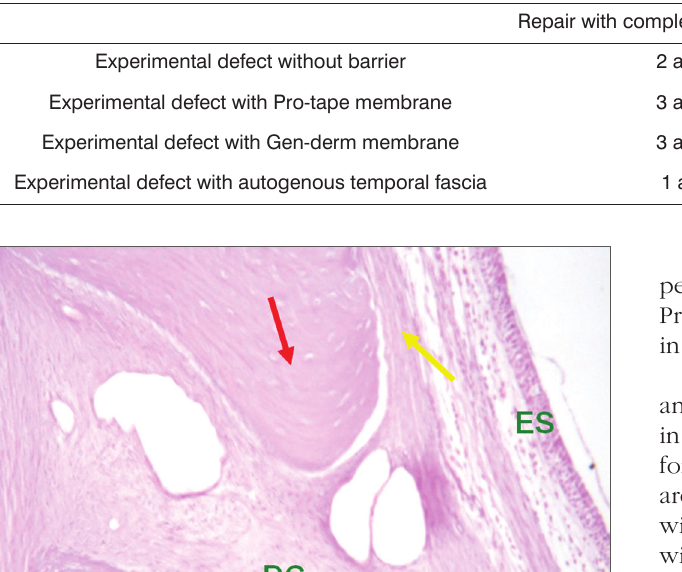
Table 1. List of experimental surgical defects (control, with collagen membranes Pro-tape, Gen-derm, and temporal fascia) and the type of repair (completely neoformed bone, and fibrous connective tissue).